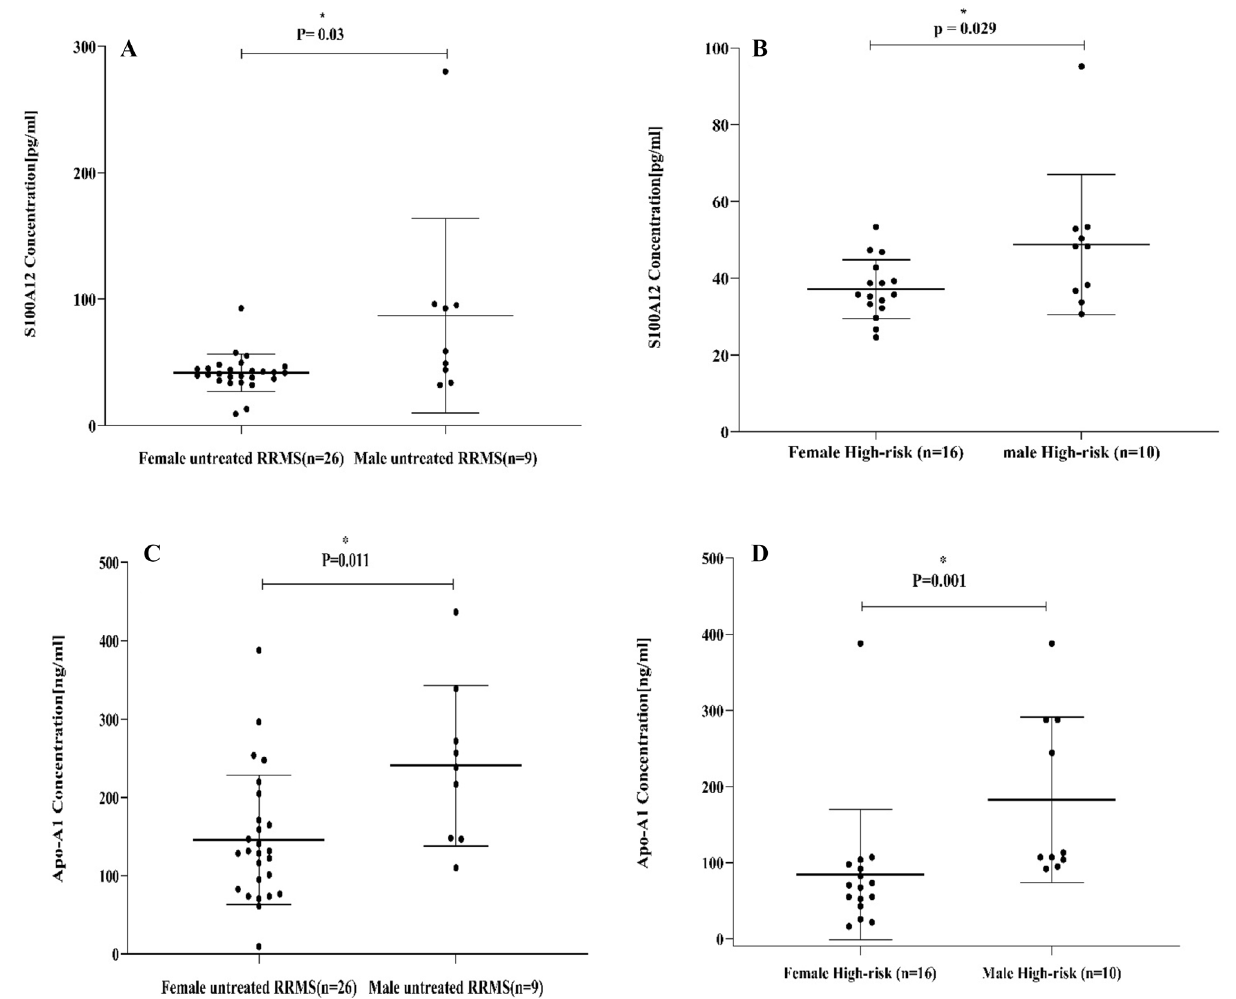
Figure 3. In the new cases untreated RRMS patients, S100A12 level was declined in the female more than in males (Mann–Whitney; p = 0.03) ( A ). S100A12 level was also reduced in the females than in the males in the high-risk group (Mann–Whitney; P = 0.029) ( B ). Apo-A1 levels were decreased in the females than males in both untreated RRMS patients and high-risk groups respectively (Mann–Whitney; P = 0.011) ( C ) (Mann– Whitney; P = 0.001) ( D